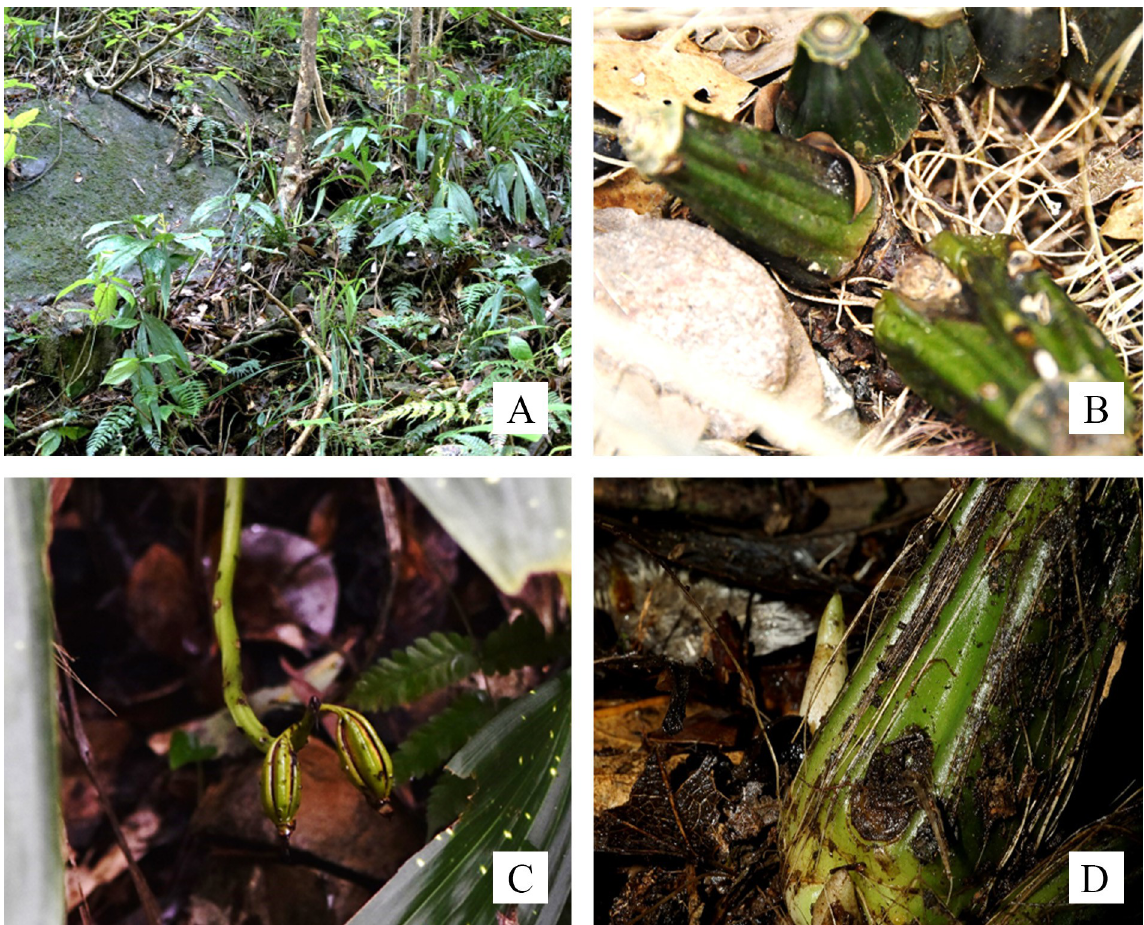
Fig 1. The habitat and growth characteristics of Phaius flavus . A. Habitat; B. pseudobulbs and fleshy stems; C. persistent dehiscent fruits; D. a budding